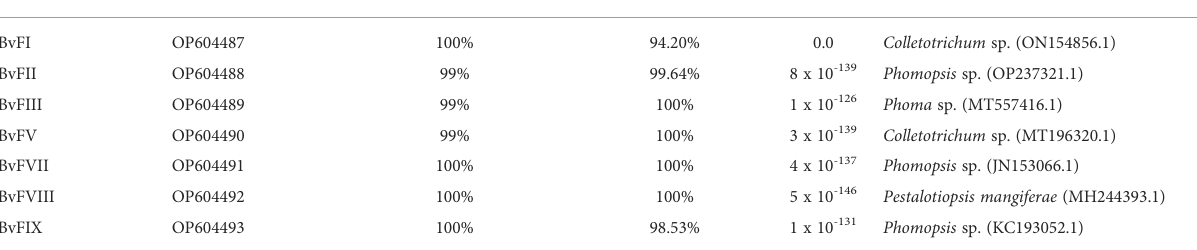
TABLE 1 Strains of endophytic fungi isolated from Bauhinia